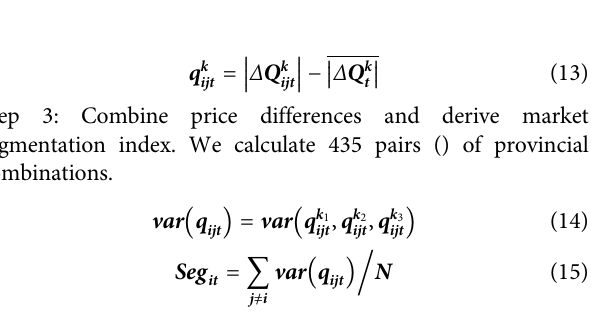
FIGURE 5 | The average value of UEIc in different regions. FIGURE 6 | Trend of market segmentation index of thermal power